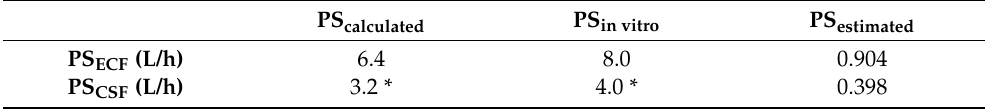
Table 2. Comparison of PS values calculated from system- and drug-specific paramaters (PS calculated ) using Simcyp, estimated by the model (PS estimated ) or scaled from in vitro Caco-2 permeability parameters (PS in vitro